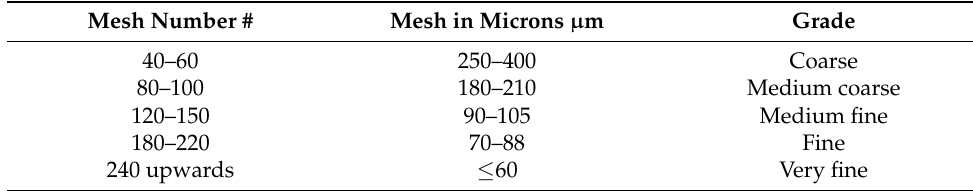
Table 6. Abrasive mesh size and grade